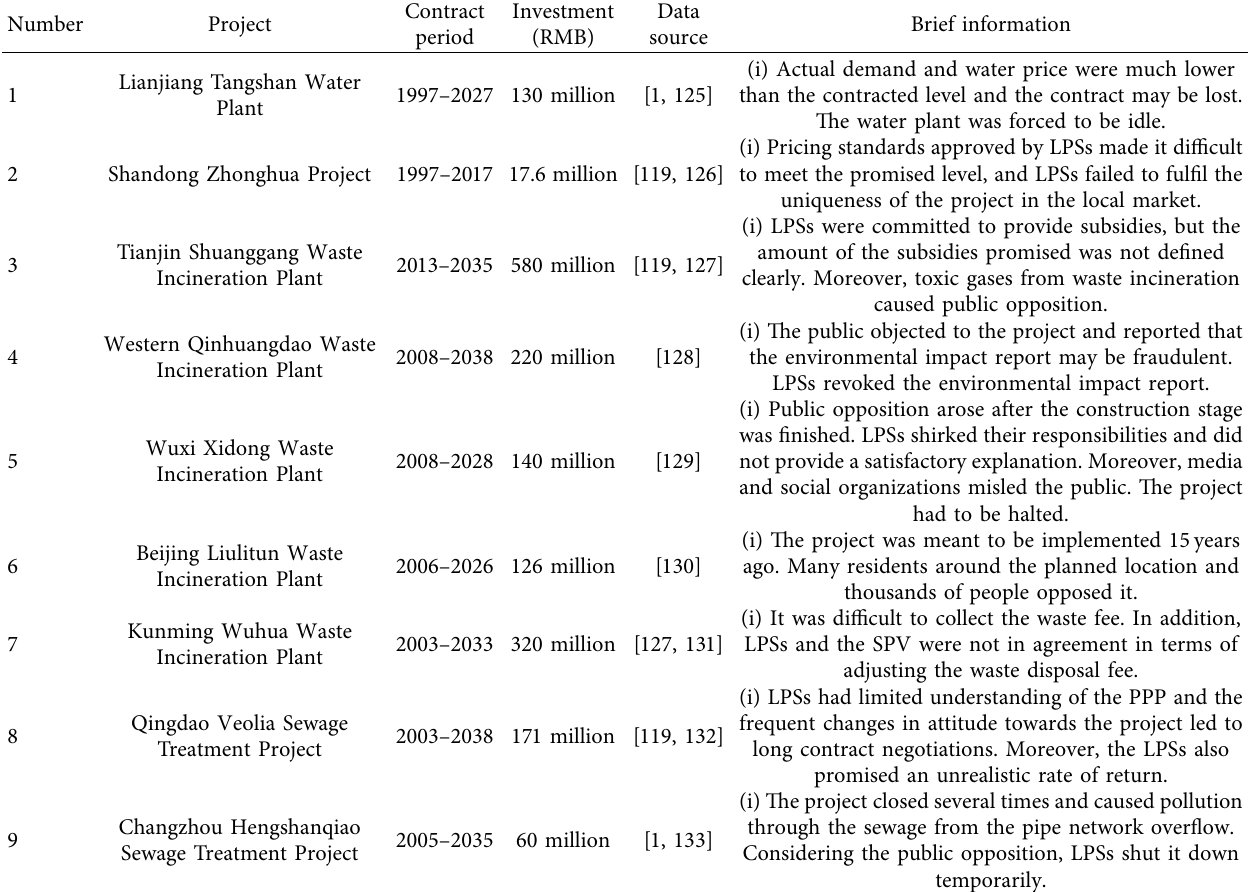
Table 3: General information on 15 cases from ecological